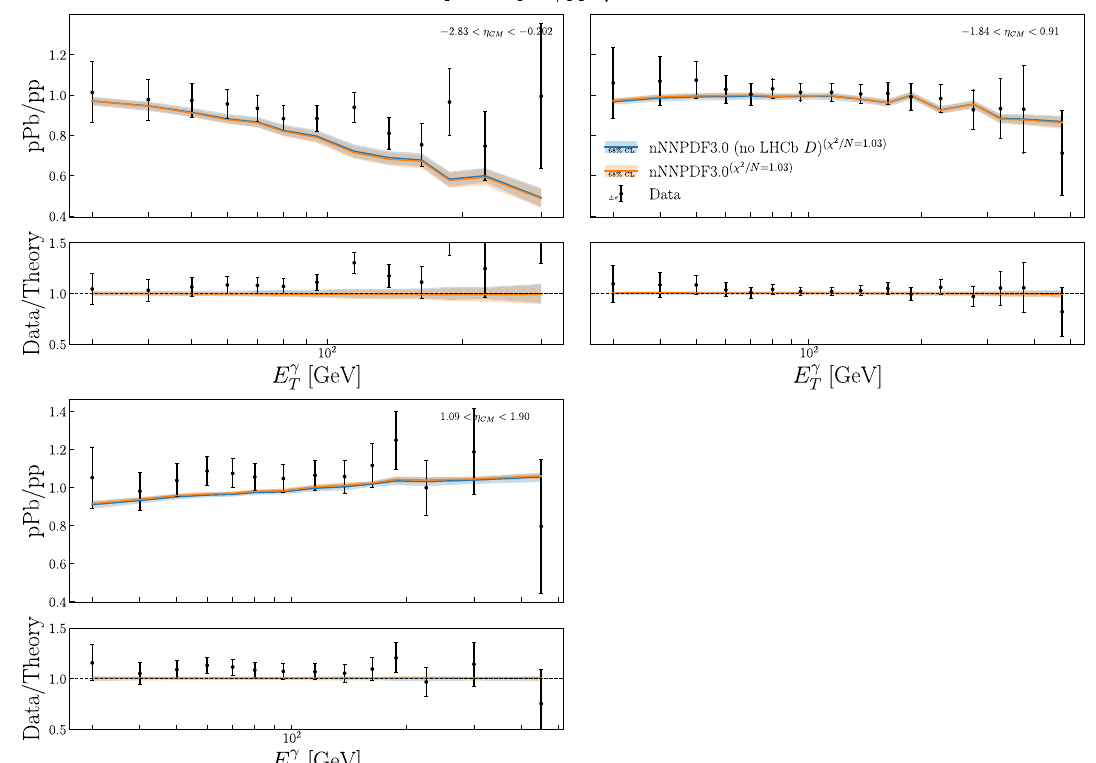
Fig. 31 Comparison between the theoretical predictions based on both nNNPDF3.0 and the variant without the LHCb D -meson cross-sections and the ATLAS measurements of the ratio of isolated photon produc- tion spectra between pPb and pp collisions at are presented differential in the photon transverse energy E